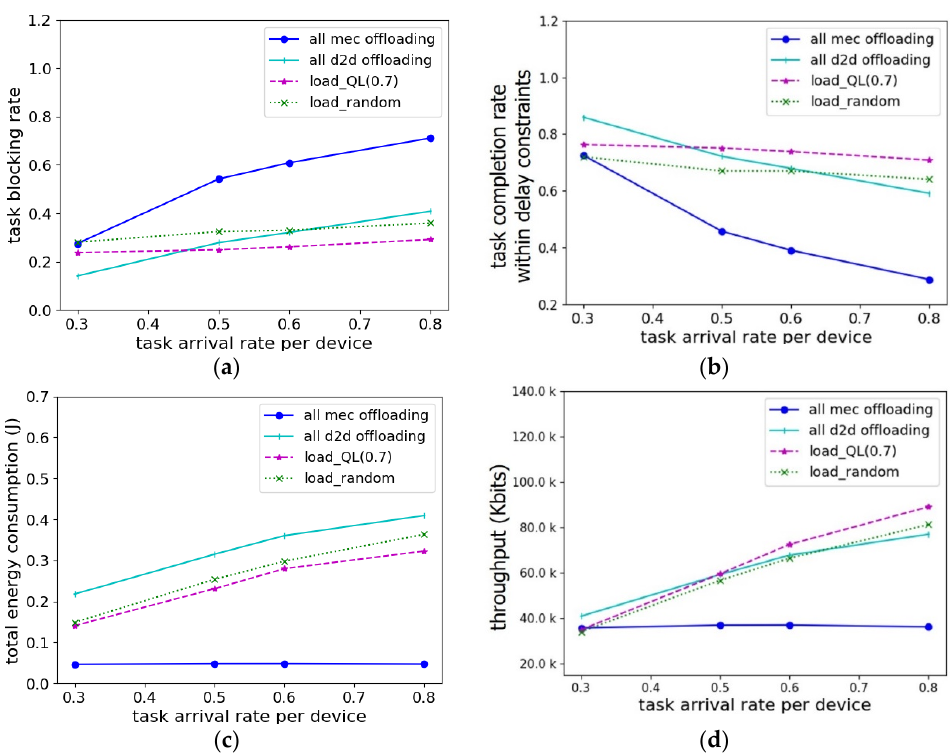
Figure 2. Performance comparison according to task arrival rate per device and the system architecture: ( a ) task blocking rate; ( b ) task completion rate within delay constraints; ( c ) total energy consumption ( J ); ( d ) throughput.